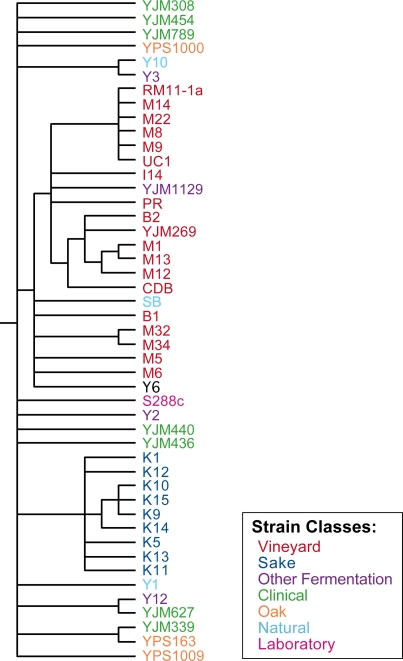
Phylogeny of Saccharomyces strains used in this
study.The phylogeny was inferred from 13,061 bp of coding and non-coding
sequence generated by [2] and this study, using the program
MrBayes [73]. Nodes with a posterior
probability<0.9 are collapsed. Strains are color coded according
to the niche from which they were originally isolated, as shown in the
key at the bottom of the figure.